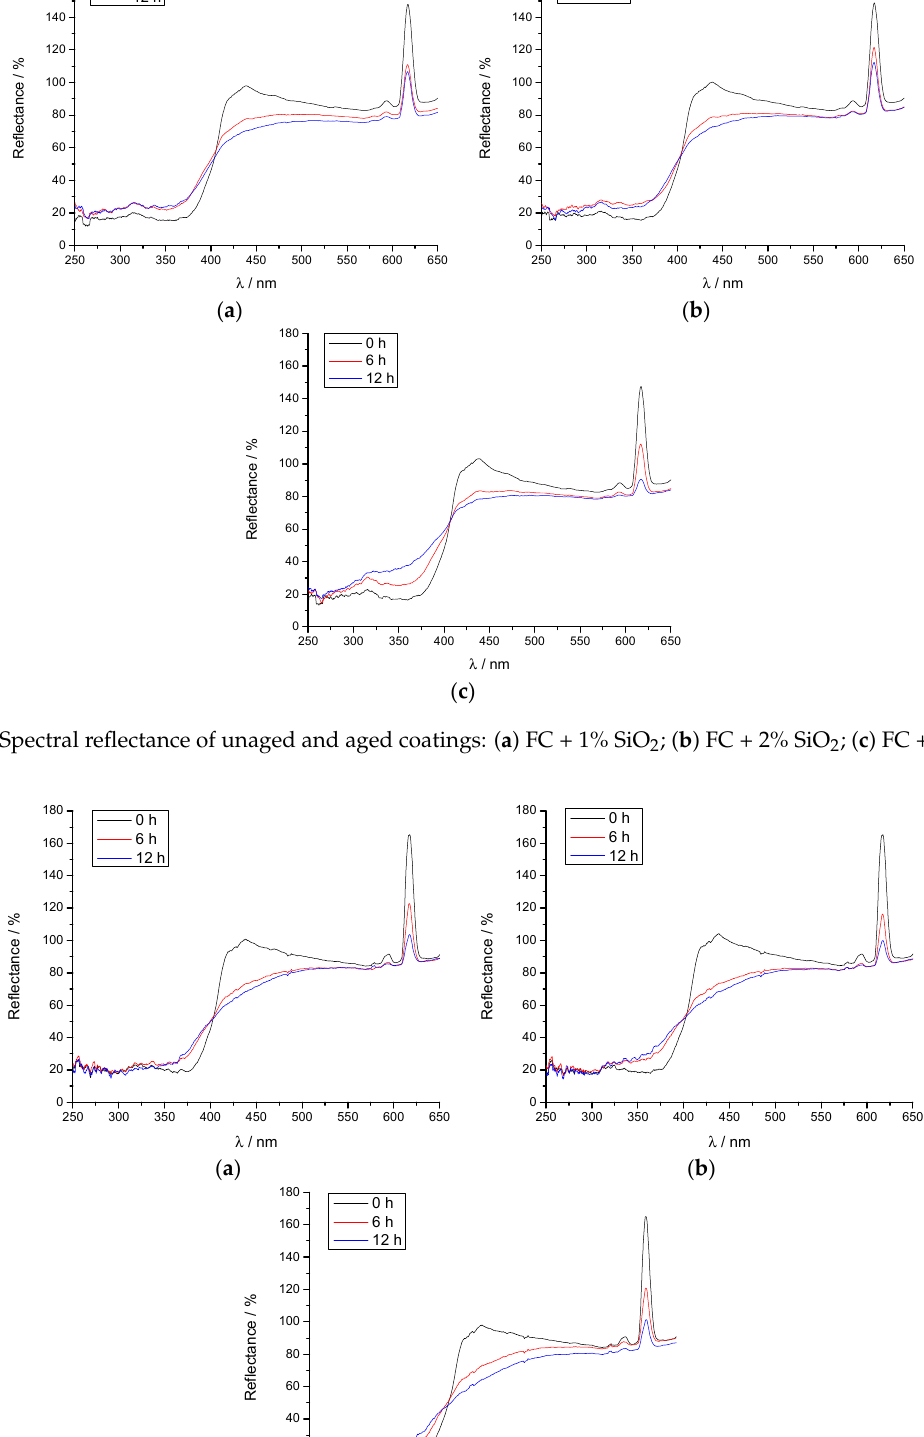
Figure 4. Spectral reflectance of unaged and aged samples: ( a ) transparent base; ( b ) TB + FP (without the nanoparticles).